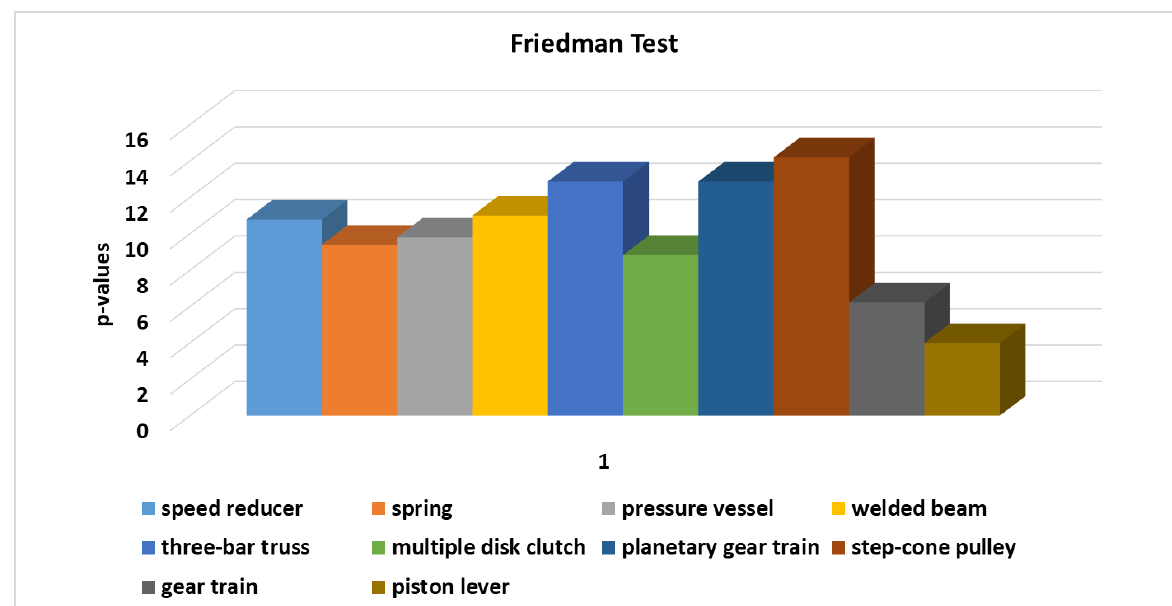
Figure 11. Comparison of Friedman’s p -vales for different design examples.